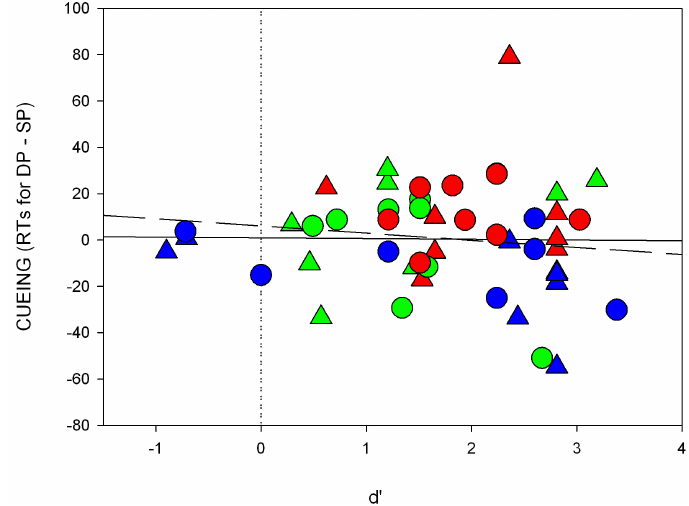
Figure A6. Individual scatter plots of the short SOA for Experiment 6. Shown are RT differences (cueing effects, y -axis) and the respective d’ -value ( x -axis) for each participant separately. Values are plotted separately for cues with the same (triangles; solid regression line) and a different color (circles; dashed regression line). Symbols are colored corresponding to the respective searched-for target